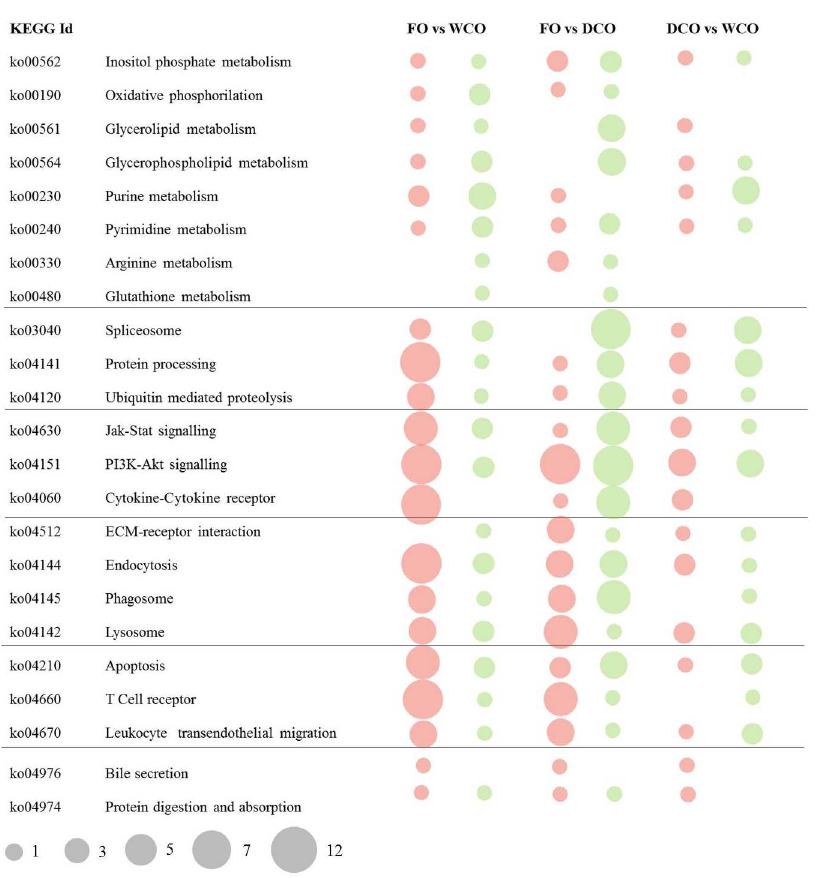
Fig 5. Ranking of differentially expressedpathways in midgut of Atlantic salmon between fish fed a diet containing Fish Oil (FO), Wild type Camelina Oil (WCO) or EPA+DHACamelina Oil (DCO). Pathway analysiswas performed using the Kyoto Encyclopedia of Genes and Genome (KEGG). The area of the circle is scaled to the number of DEG within each pathway. Up-regulated genes, red; down-regulatedgenes, green.